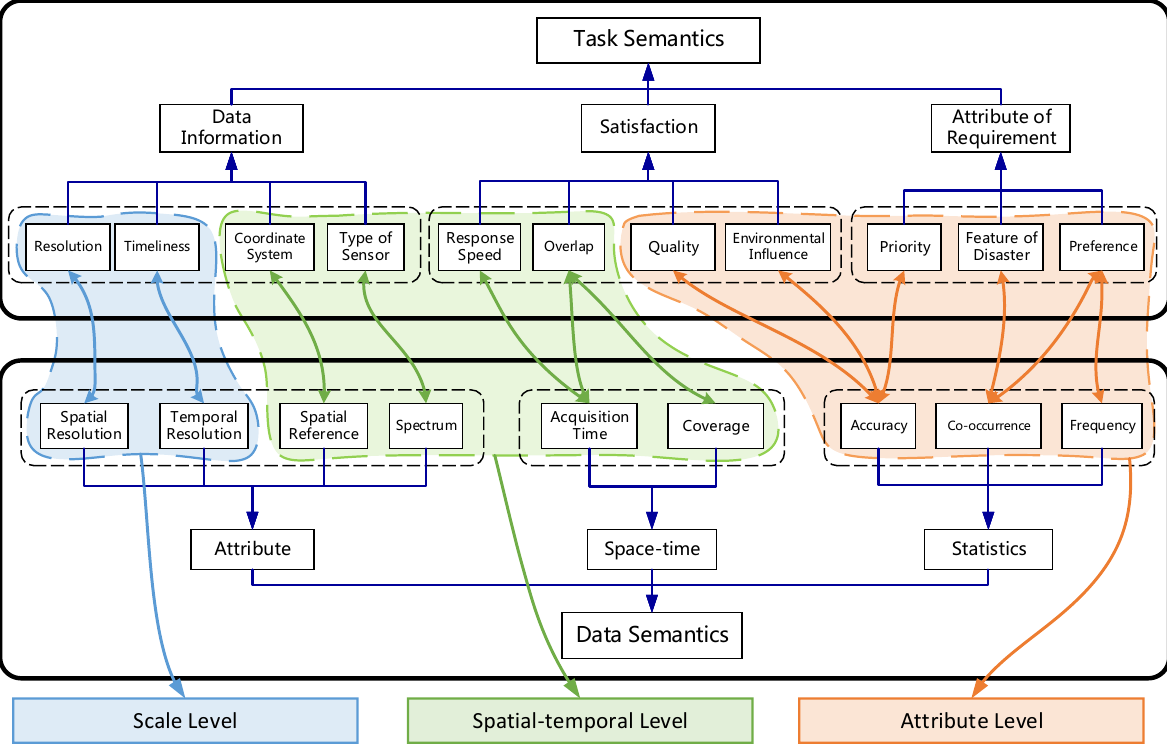
Figure 3. Semantic mapping between task and